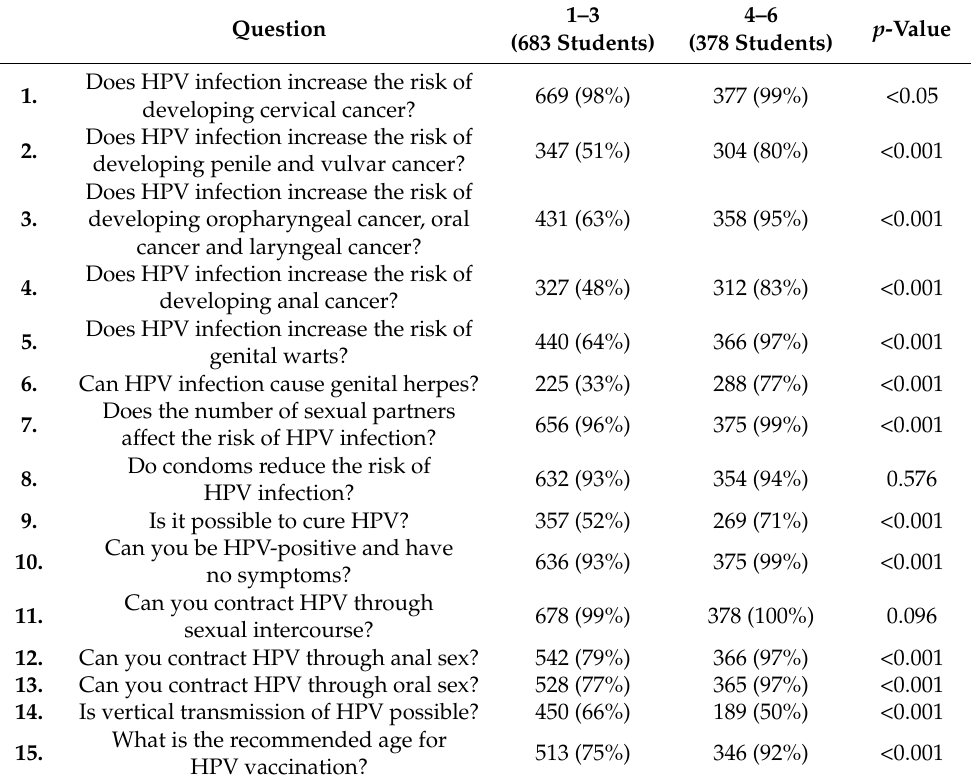
Table 2. Comparison of percentages of correct responses to particular questions provided by